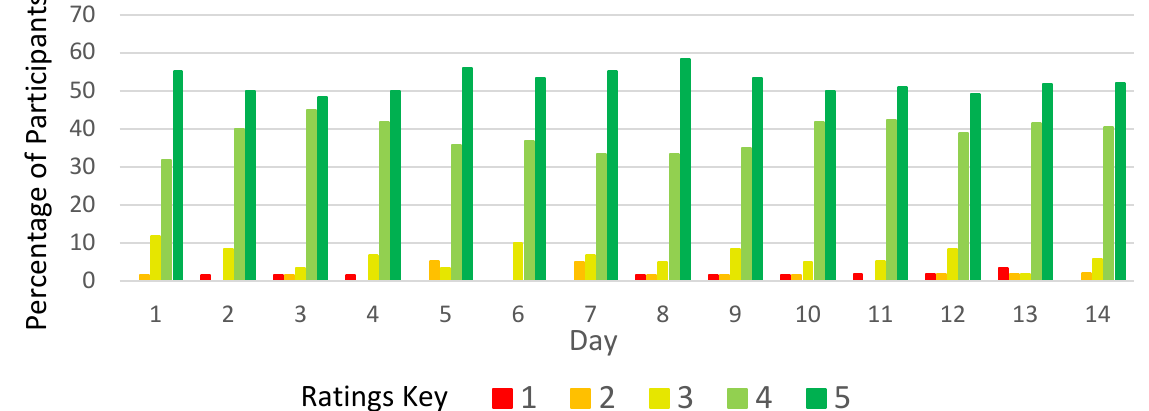
Scheme 12. Parent survey results for: Dispensing the multiparticulate.